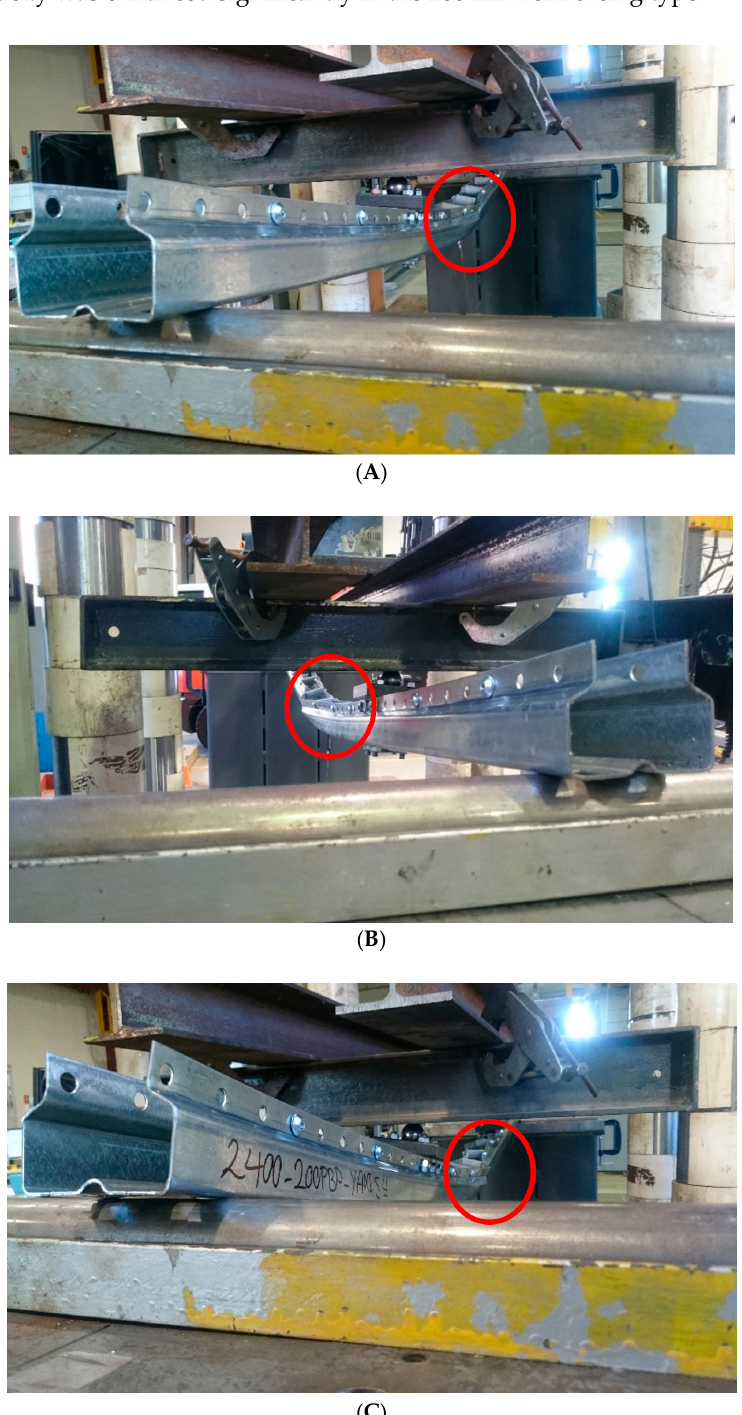
Figure 18. The observed failure mode for reinforced specimens with 200 mm reinforcing pitch during the minor axis test: ( A ) 200RMIM-test1; ( B ) 200RMIM-test2; ( C ) 200RMIM-test3.